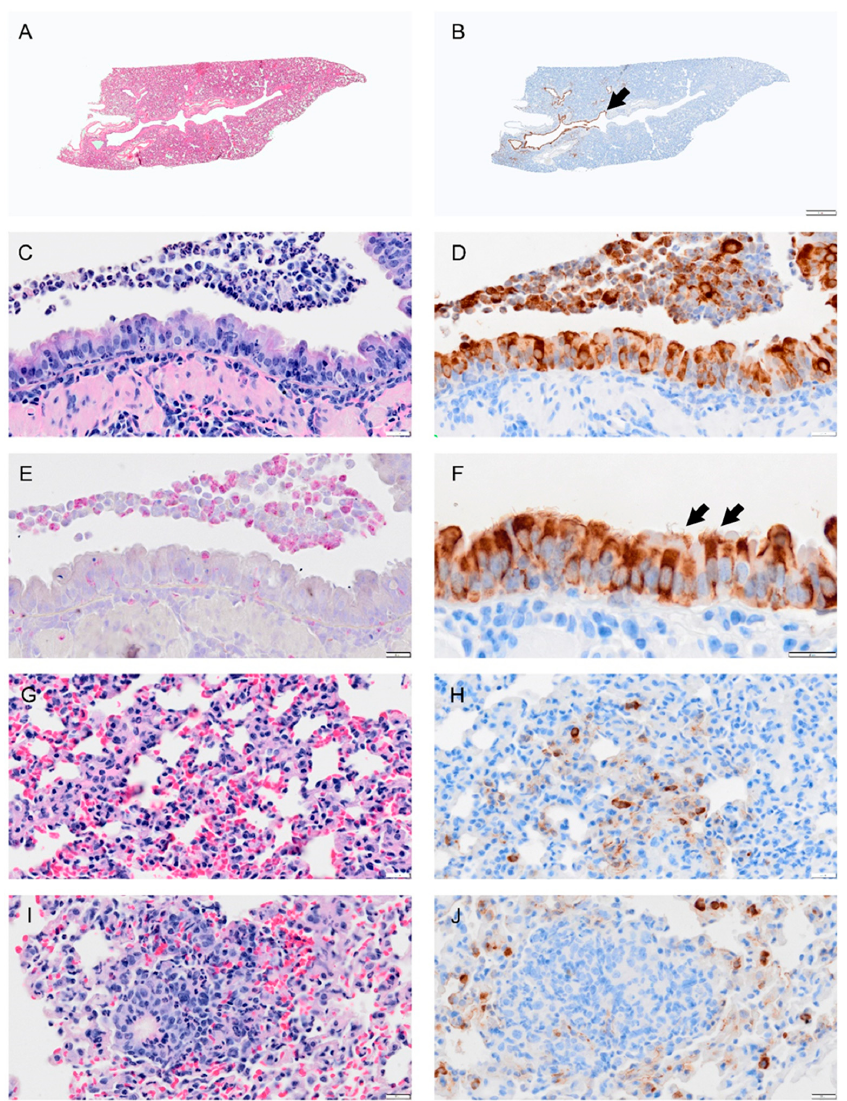
Figure 4. Selected pathology and immunohistochemistry of lungs from Syrian hamsters at 1 dpi with SARS-CoV-2. ( A ) Lower magnification of a H&E-stained section showed no marked change at 1 dpi. ( B ) Immunohistochemistry (IHC) of SARS-CoV-2 in lung section shows distribution of the virus in the bronchial epithelium of primary and secondary (segmental) bronchi (brown color arrowhead) and in some scattered areas of alveolar tissues. ( C ) H&E-stained section of bronchus showing inflammatory cell infiltration in bronchial wall (mucosa and submucosa) and cell debris (neutrophils, macrophages, necrotic epithelial cells) in lumen. ( D ) Adjacent serial sections of panel ( C ) show abundant infected epithelial cells in mucosa and debris. ( E ) Adjacent serial section with NACE stain shows neutrophils in debris, epithelium, and submucosal layer. ( F ) Higher magnification of virus IHC shows disorganized bronchial epithelial cells with disorganized cilia, see arrow. ( G ) H&E-stained section of alveolar tissue showing intravascular neutrophils and congestion. ( H ) Adjacent section of panel ( G ) stained for virus by IHC shows virus antigen concentrated in type 2 alveolar cells, with small amounts lining alveolar surfaces. ( I ) Section showing inflammatory cells in areas of alveolar collapse, representing early consolidation. ( J ) Viral antigen concentrated within type 2 pneumocytes surrounding consolidation area. Bar: ( A , B ) = 1 mm; ( C – J ) = 20 µ